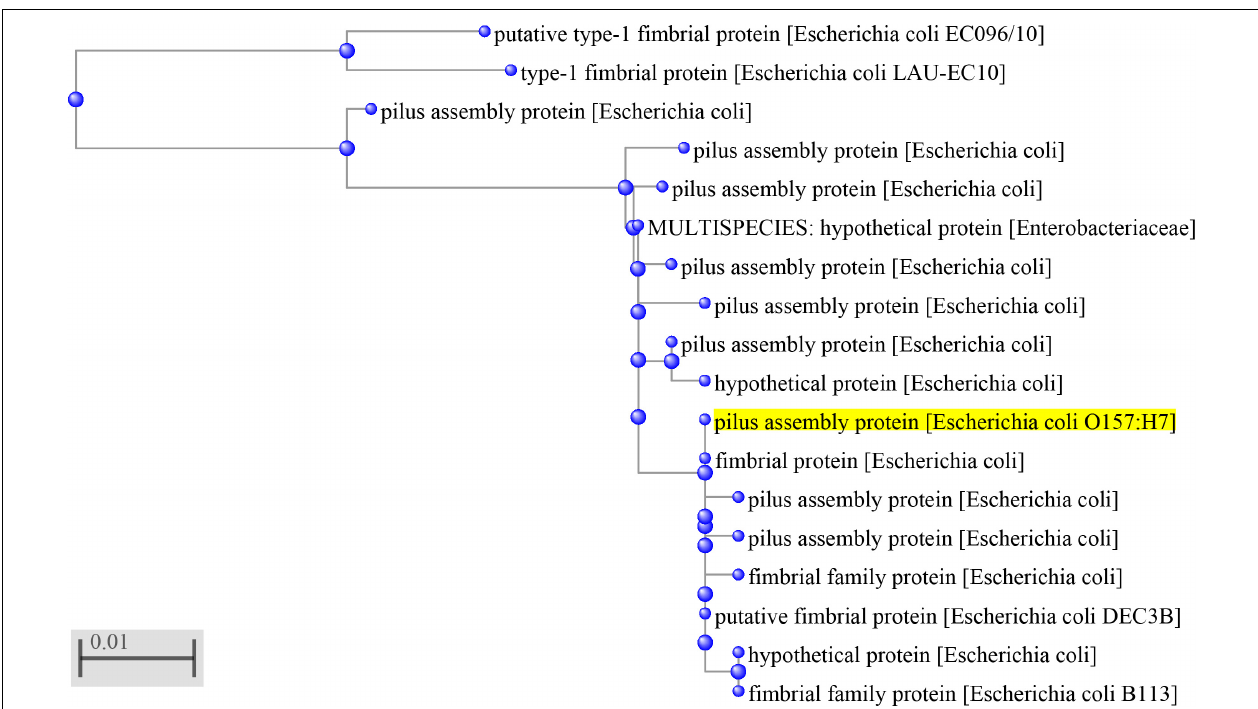
FIGURE 1 | Phylogenetic relationships between Z3276 protein and other fimbrial proteins. The phylogenetic tree was generated by BLAST in GenBank with Z3276 protein (yellow) encoded by the entire z3276 gene from EHEC O157:H7 genome. The scale bar represents 0.01 nucleotide substitutions per site.